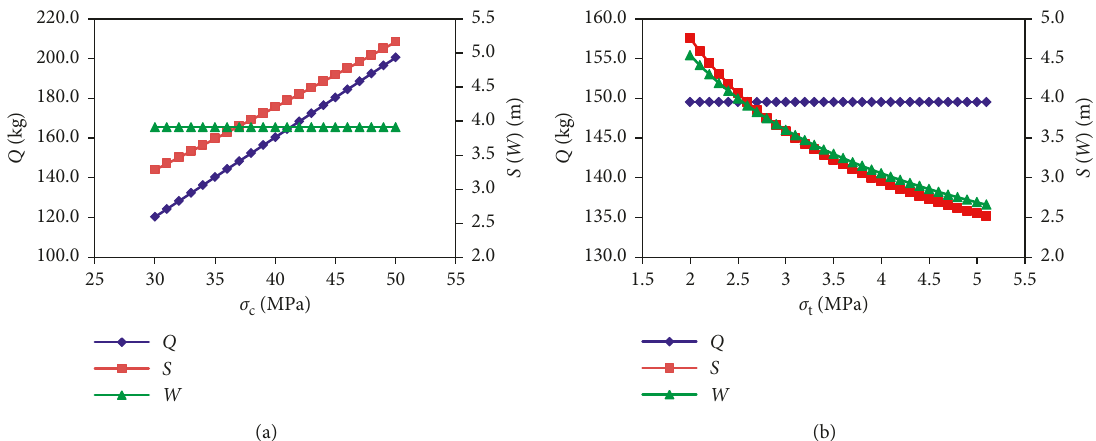
Figure 7: Relationships of Q , S , and W with σ